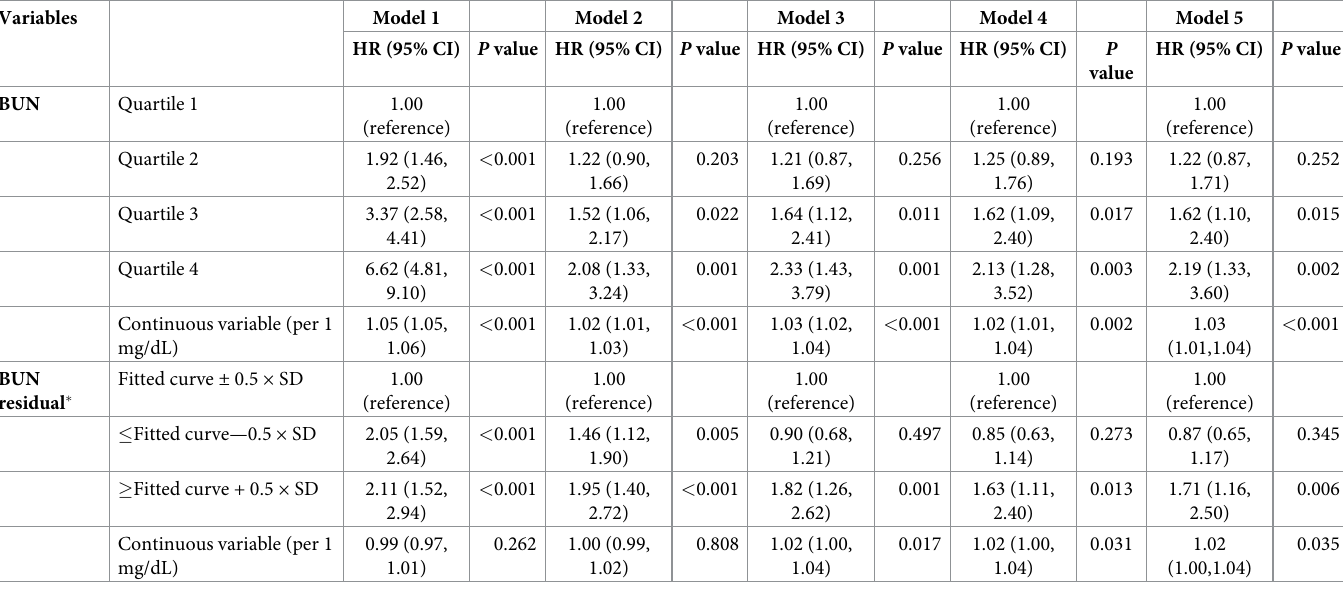
Table 4. Cox regression analysis of the relationship between BUN, BUN residual, and anemia development.